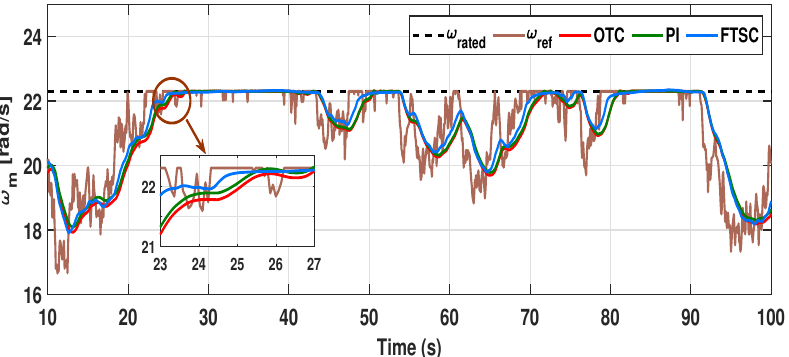
Figure 18. Dynamic response of rotor speed under proposed system in comparison with OTC and PI controllers for varying wind profile case-II .